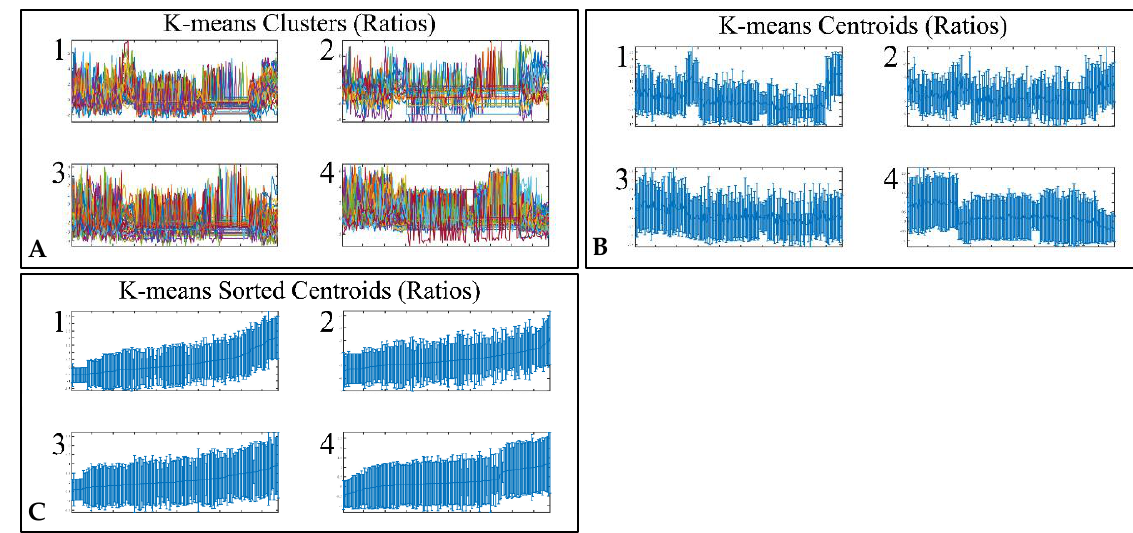
Figure 3. Unsupervised k-means clustering of DE miRNAs. Clustering resulted in four clusters ( A ), which are presented with their centroids ( B ) and the respective sorted centroids ( C ).